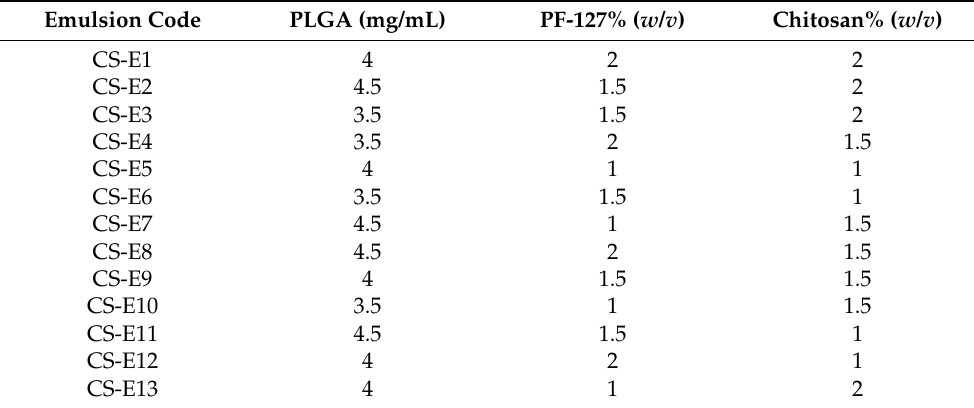
Table 1. Compositions of the chitosan-coated PLGA NPs with formulation codes for the experiments generated by